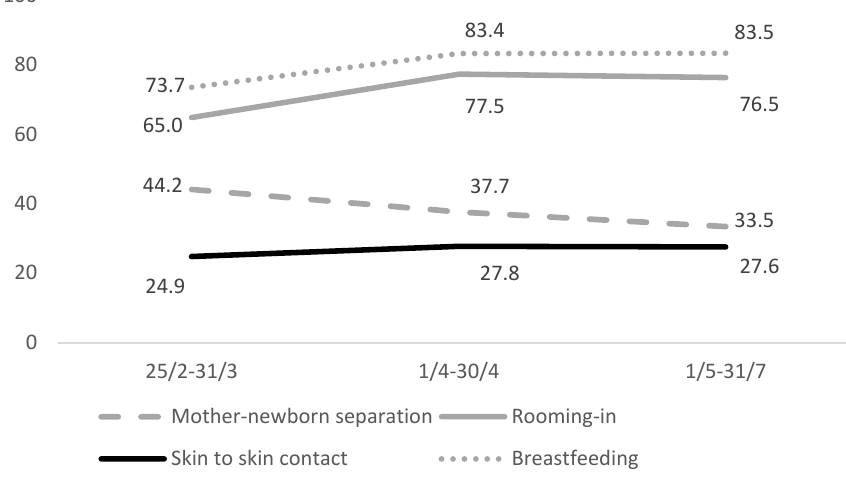
Figure 2. Temporal trend of peripartum care indicators.